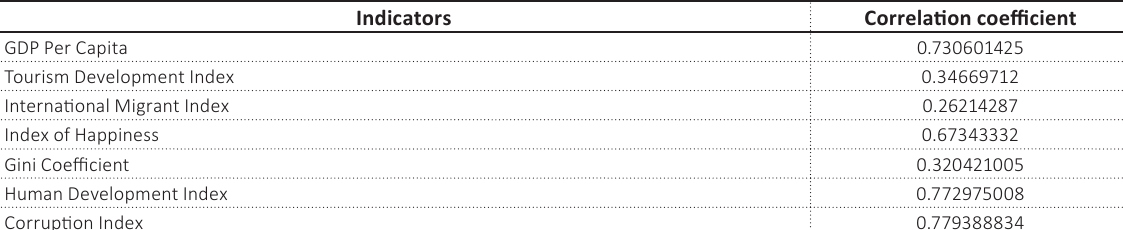
Table 3. Relationship between the indicators and Rainbow Europe Index